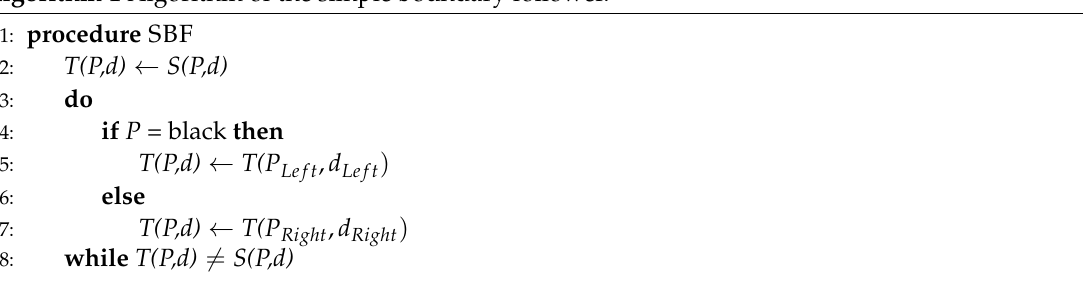
Algorithm 1 Algorithm of the simple boundary